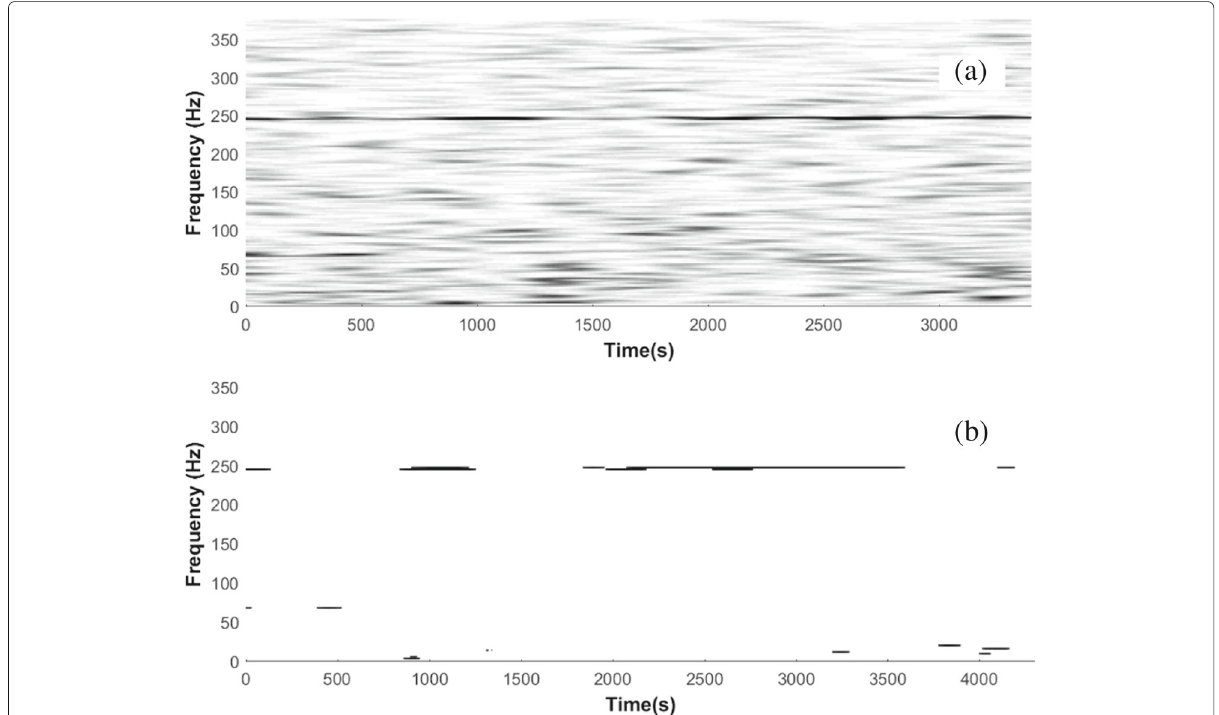
Fig. 9 a Simulated valid electrode spectrogram and b spectrogram after applied K-means denoising